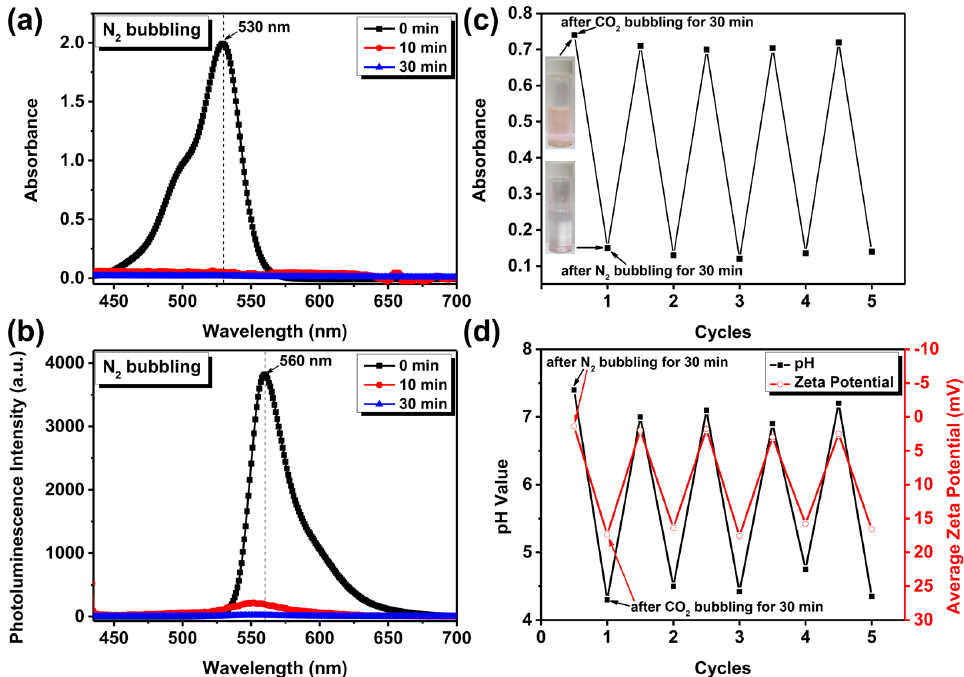
Figure 3. ( a ) UV-Vis and ( b ) PL spectra of CO 2 -treated I-R6G (0.1 mg/mL) in water bubbled with N 2 for various periods of time at 25 °C. Reversible changes in the ( c ) absorption intensity and ( d ) pH and zeta-potential values of aqueous I-R6G solution (0.1 mg/mL) over five alternating cycles of CO 2 /N 2 bubbling at 25 °C. Each cycle lasted 1 h, with 30 min CO 2 bubbling and 30 min N 2 bubbling. The left inset photographs in ( c ) show the effects of CO 2 and N 2 bubbling on the solubility of I-R6G in water.